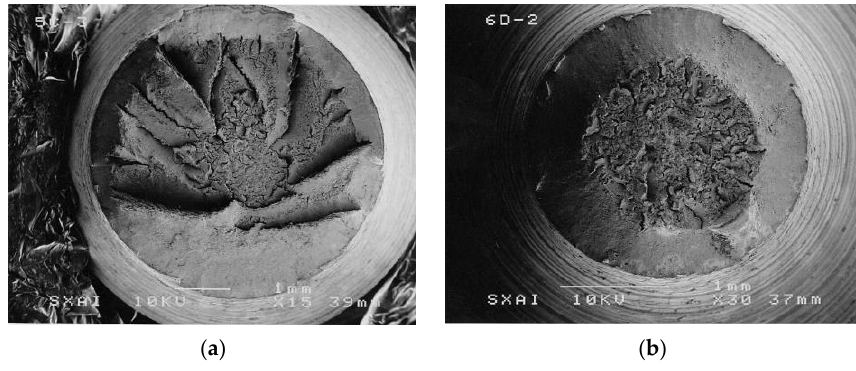
Figure 7. Sample 5C ( a ) and 6D ( b ): isotropic fracture behavior.